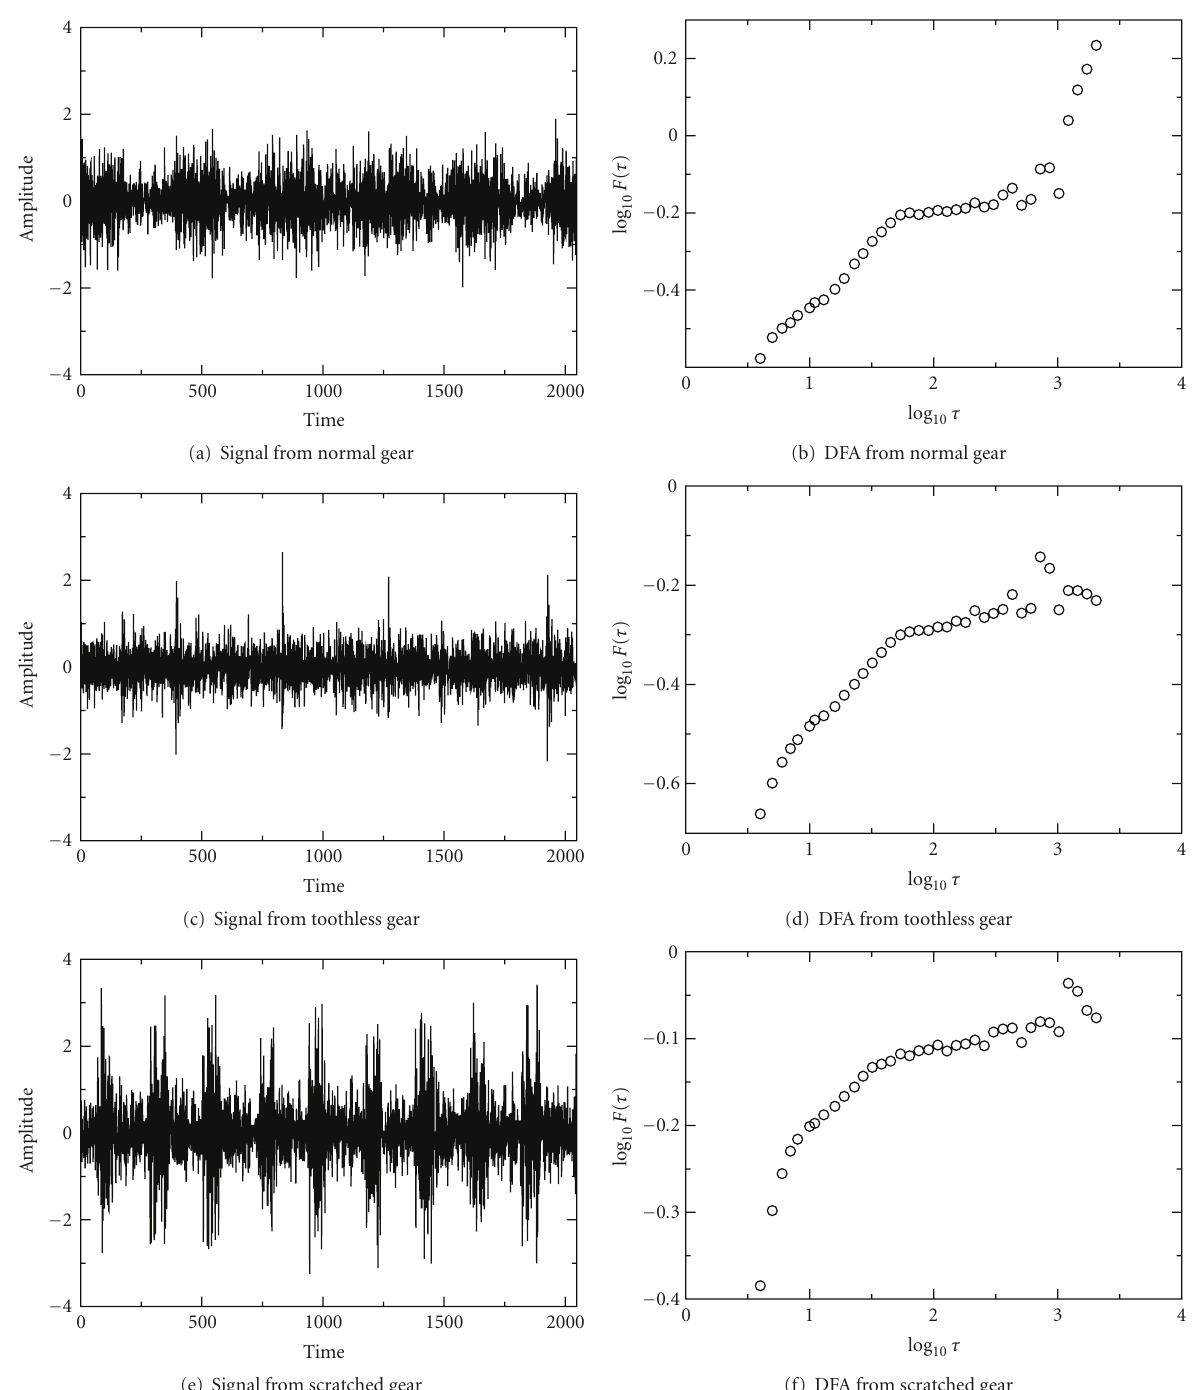
Figure 3: Representative signals and DFA curves obtained from the three types of gear, working under load at a rotation frequency of 1400 rpm. In the signal plots, time is measured in units of the inverse sampling rate.